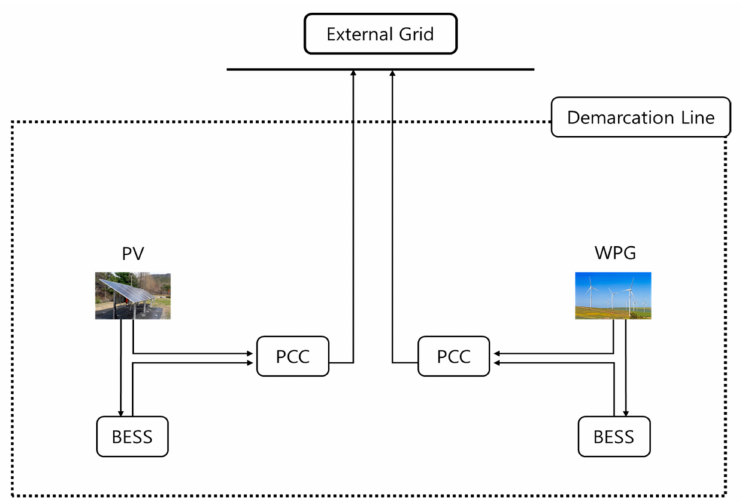
Figure 1. Available resources as a DER in the subject power